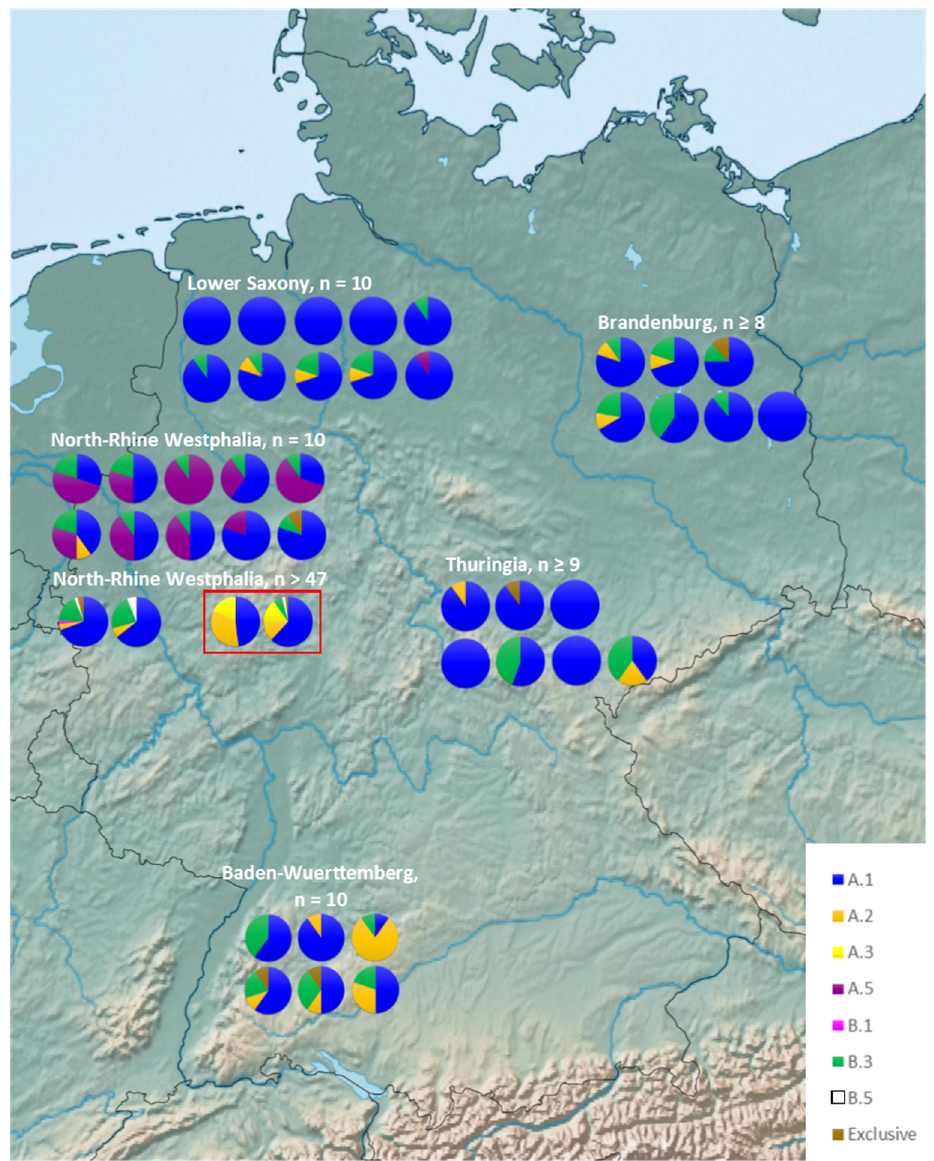
Figure 2. Haplotype distribution of Q. rubra in Germany. For better visualization, haplotypes that were exclusive to Germany and did not occur in North America (brown) are pooled together (see Table 2). Those provenances in North Rhine-Westphalia that originated from Virginia (“Sonderherkunft Bornheim”) are depicted by a red frame. “Exclusive” haplotype in those provenances is haplotype C.3. Haplotype A.5 is widespread in North Rhine-Westphalia (64% of NRW stands) and